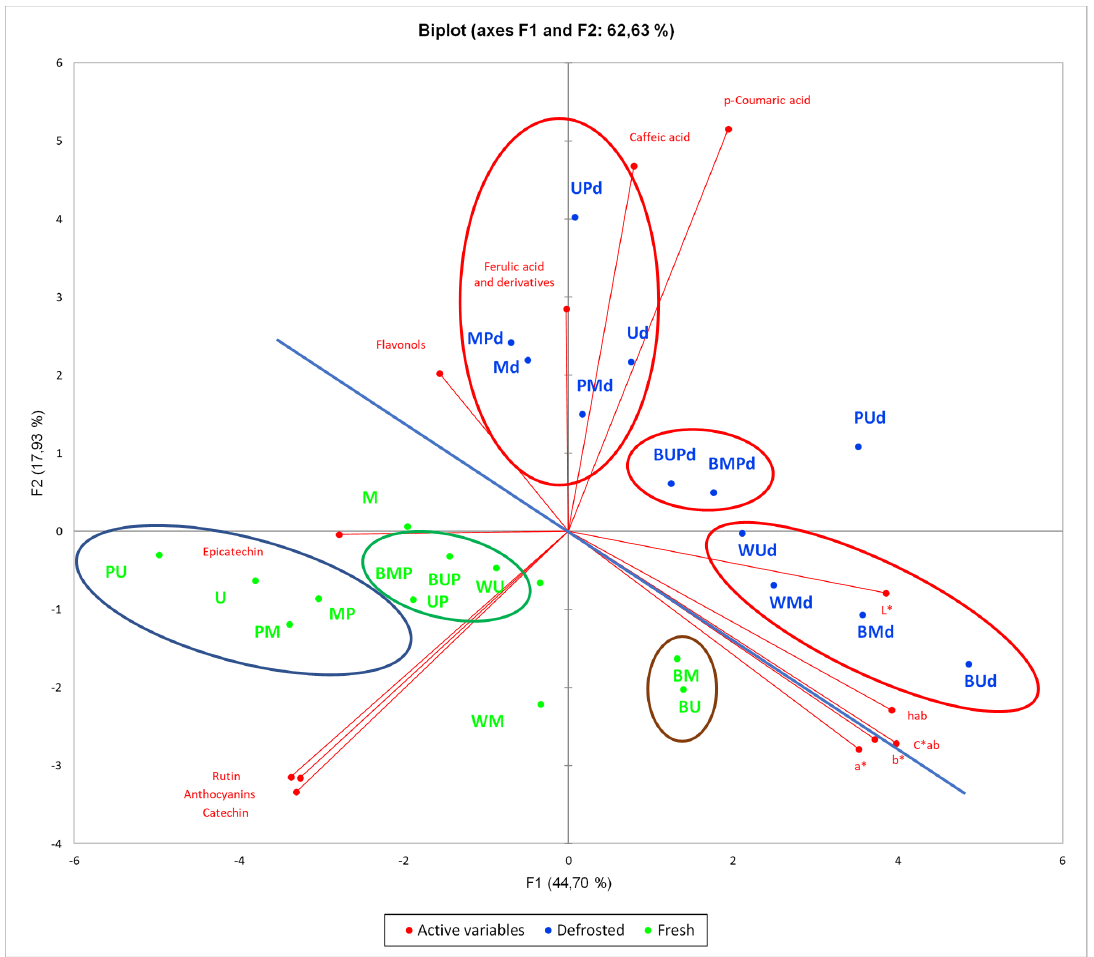
Figure 4. Principal component analysis (PCA) plots of the all strawberry Clery samples analyzed.